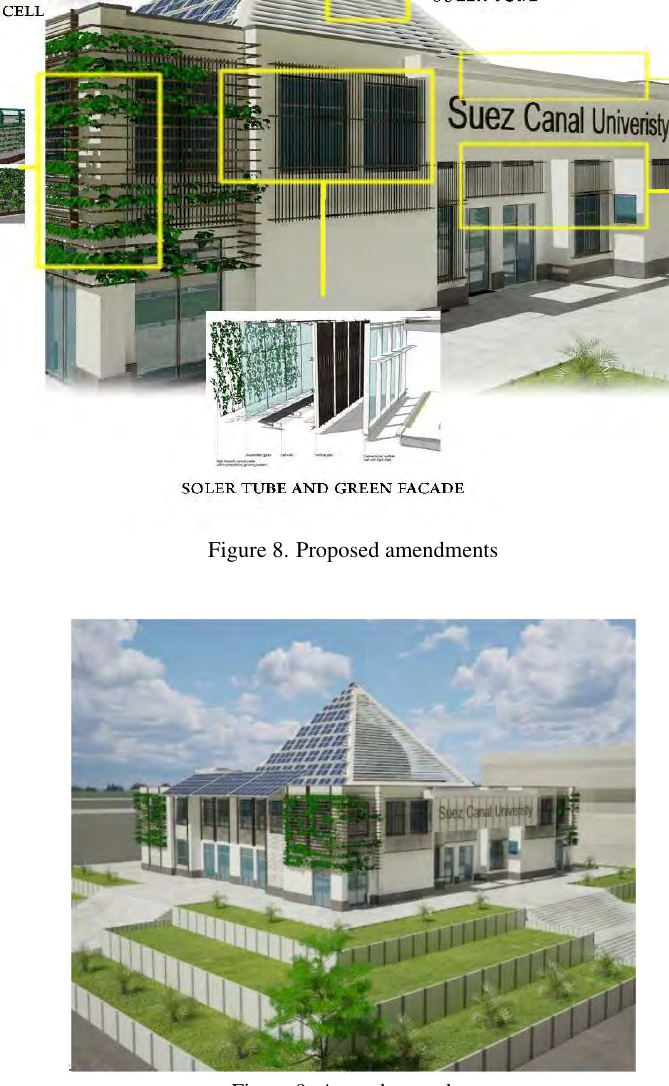
Figure 9. A-south east